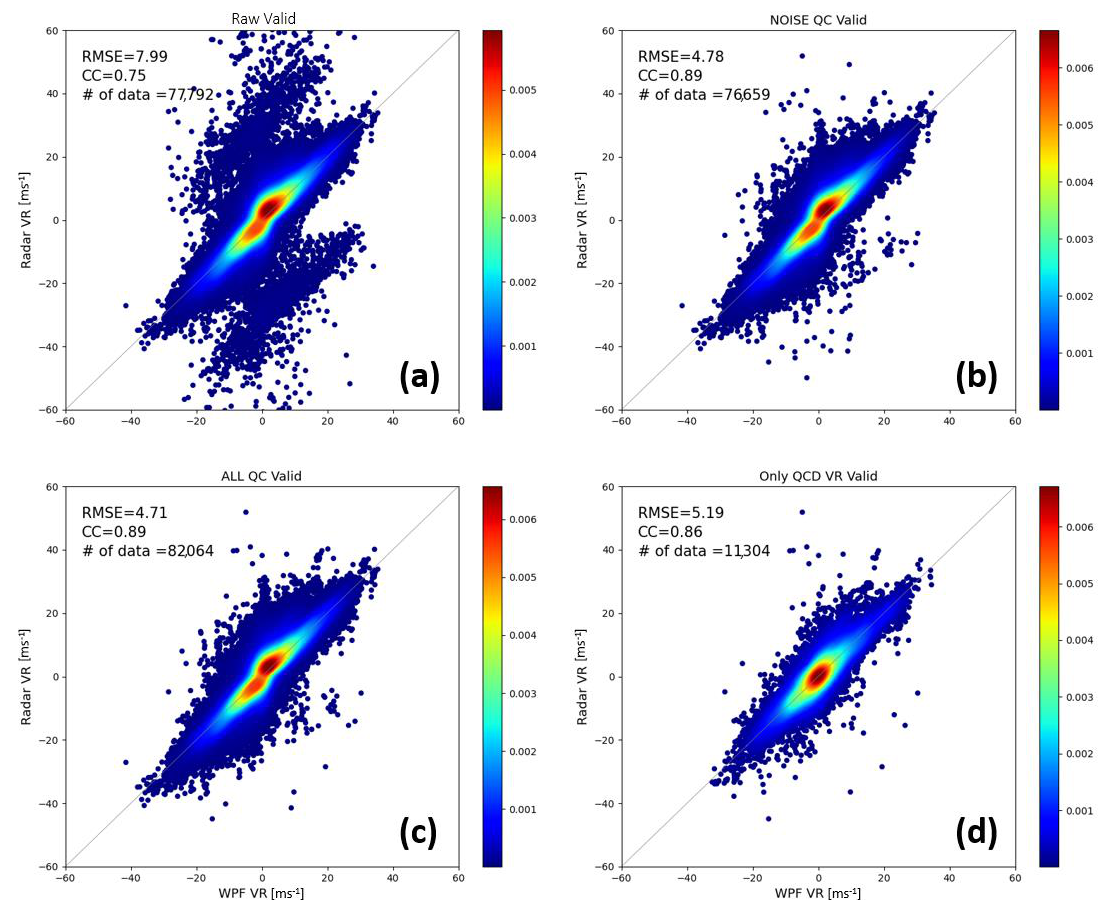
Figure 15. Two-dimensional normalized frequency distributions (NFDs) of radial velocity between the radars and the wind profilers ( a ) before noise correction (RAW), ( b ) after noise correction (NOS), ( c ) after quality control (ALL), and ( d ) only quality controlled radial velocity (QCD).